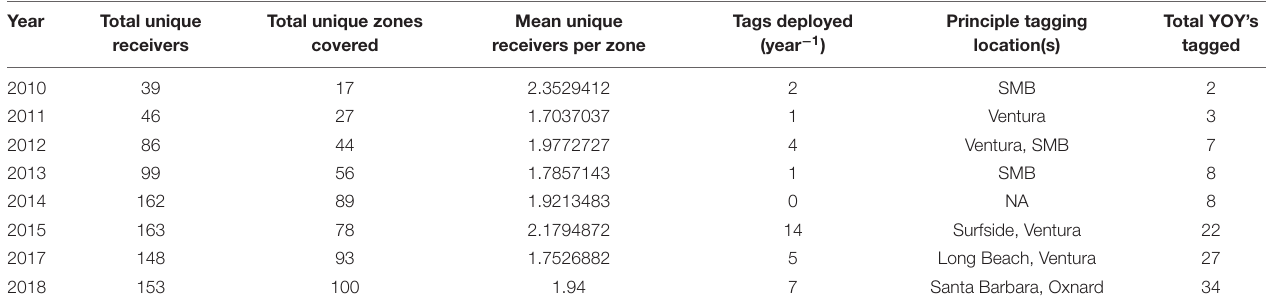
TABLE 1 | Receiver and tag deployment details across all years included in the